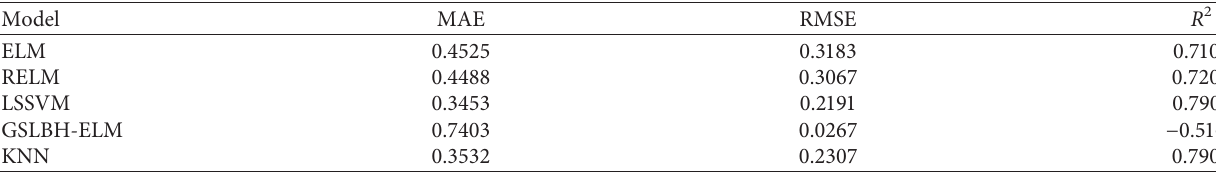
Table 8: Quantitative indicators under different soft-sensor models.